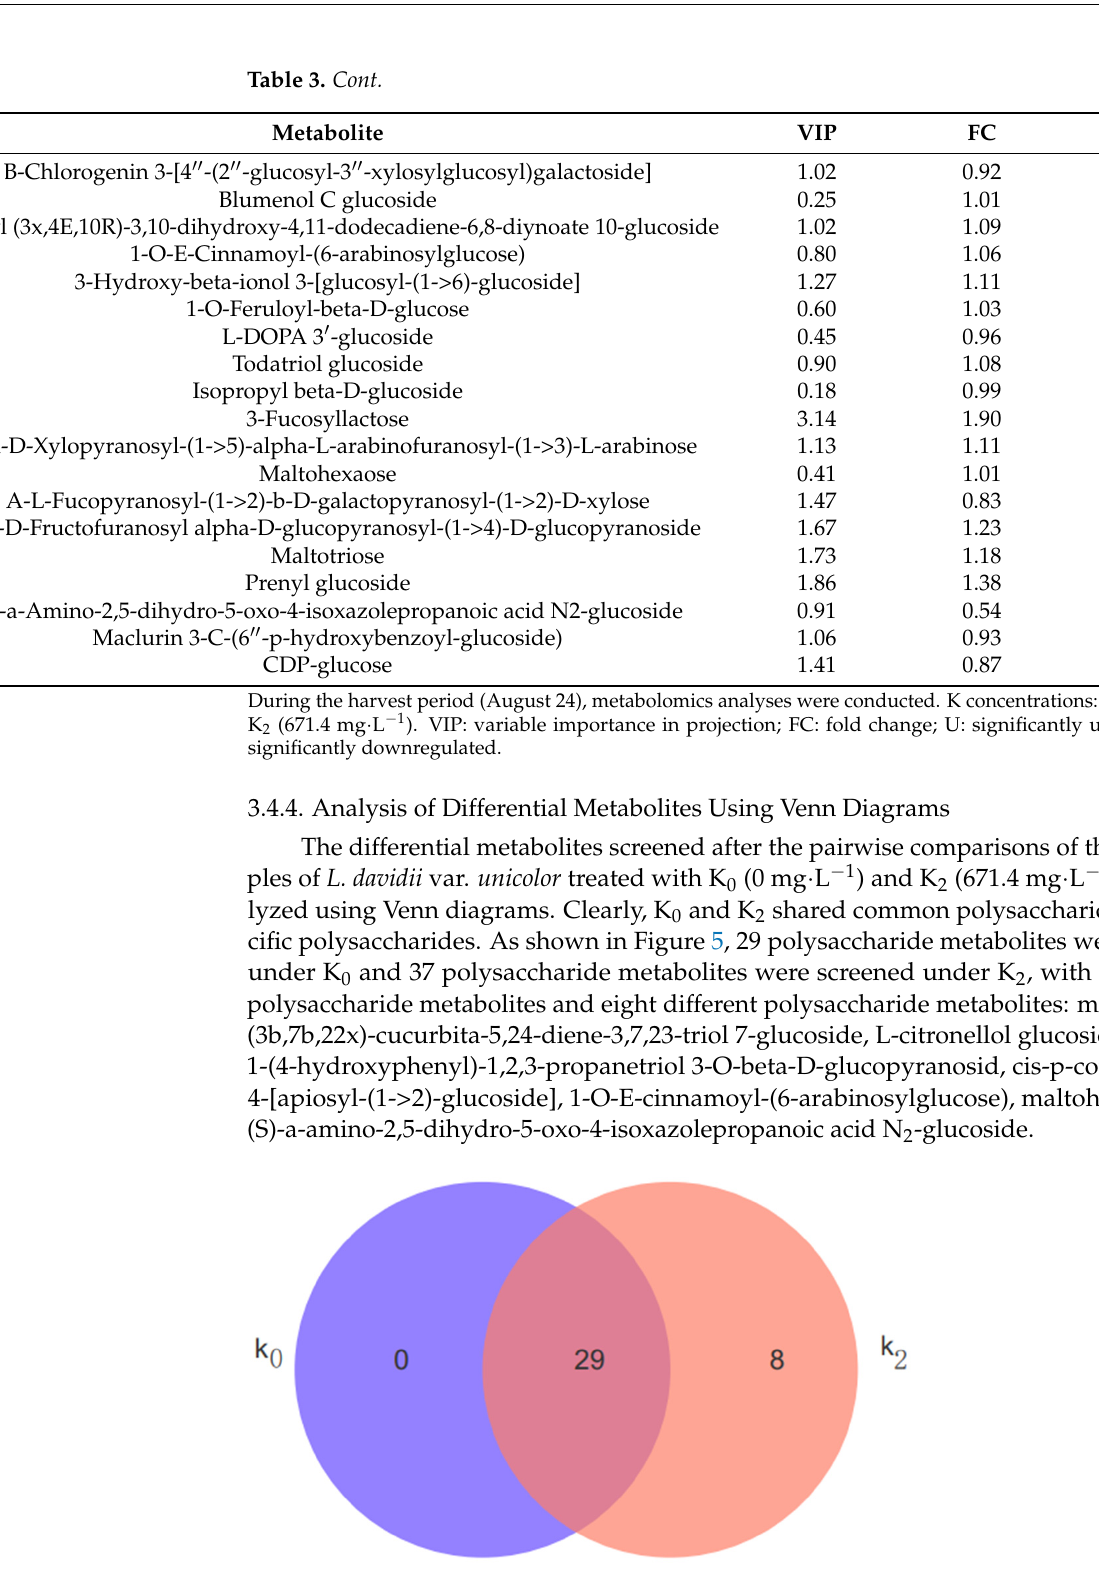
Figure 5. Venn diagram of differential metabolites under K 0 and K 2. K concentrations: K 0 (0 mg · L − 1 ), K 2 (671.4 mg · L − 1 ). The overlapping portions in the figure represent the number of metabolites shared by multiple metabolic sets, the non-overlapping portions represent the number of metabolites unique to the metabolic set, and the numbers represent the number of corresponding